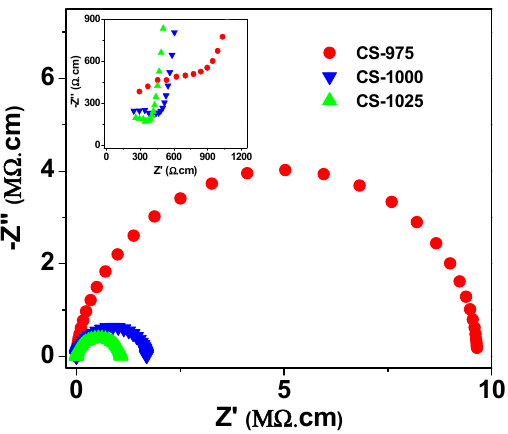
Figure 5. Impedance complex plane plot of LCTO ceramics at 300 K where the inset shows the magnification at high frequencies.